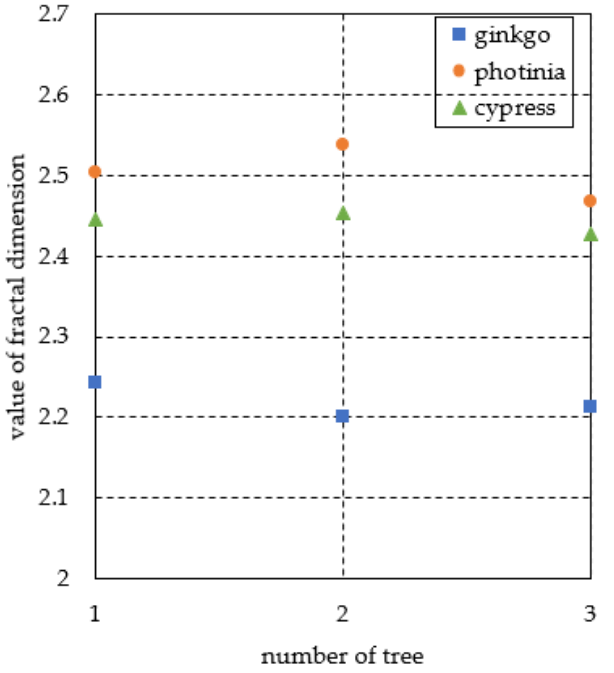
Figure 10. Fractal dimension distribution of different tree species.